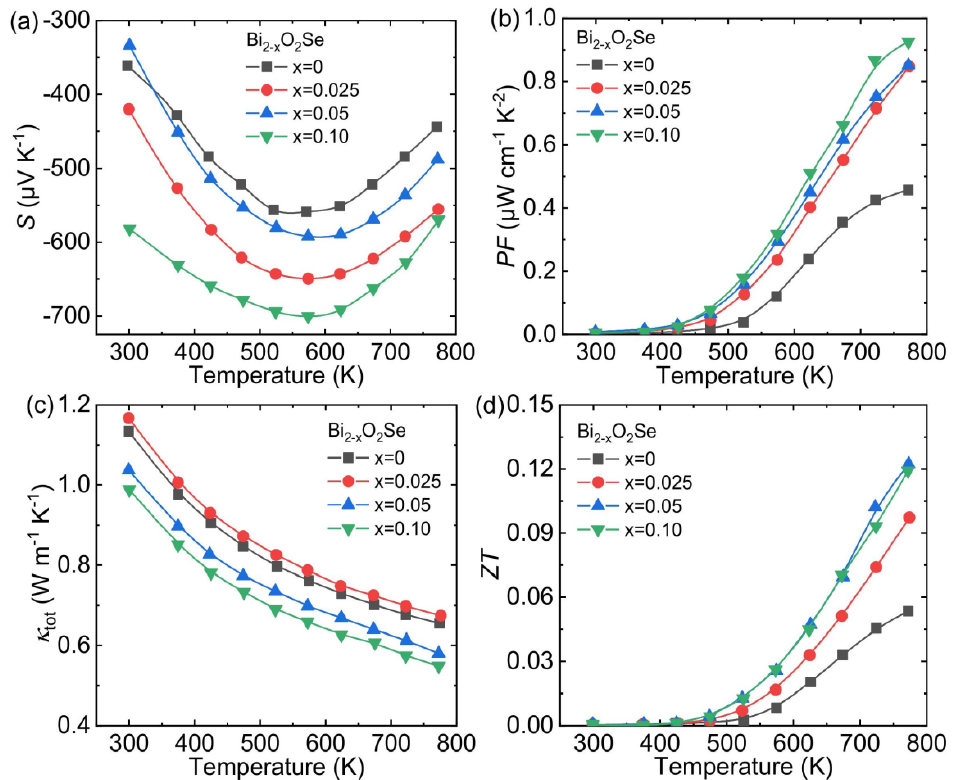
Figure 6. The temperature-dependent thermoelectric transport properties of Bi 2-x O 2 Se ( x = 0–0.10): ( a ) Seebeck coefficient, ( b ) power factor, ( c ) total thermal conductivity and ( d ) ZT . Data shown in ( a – d ) were adopted from Reference [46]. Copyright 2015, The American Ceramic Society.